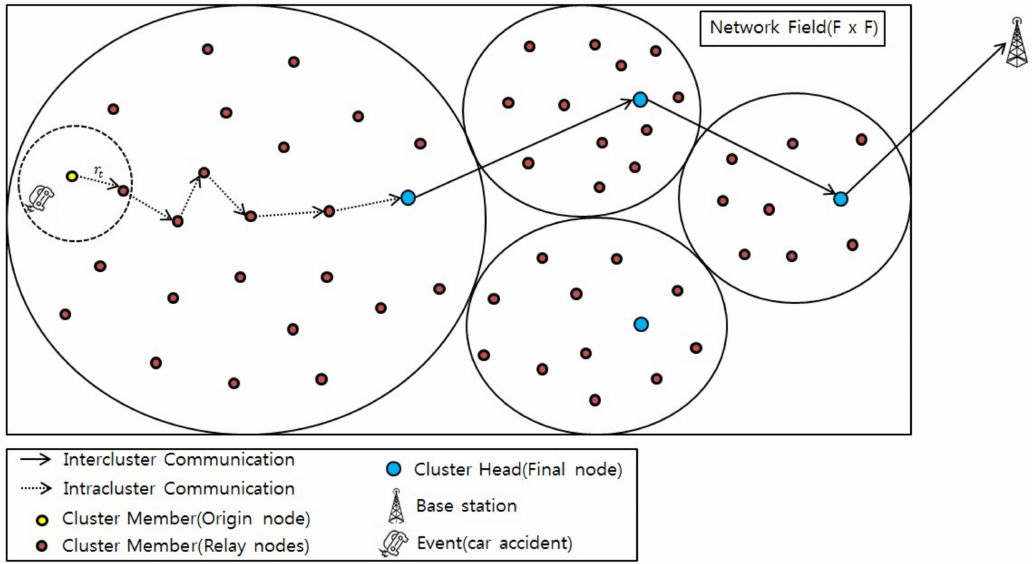
Figure 2. Network topology of proposed